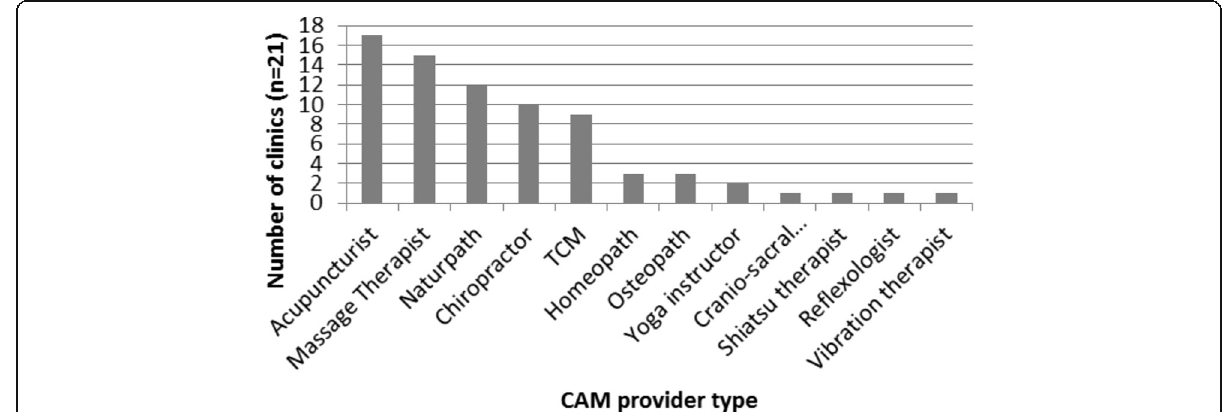
Fig. 1 Number of study sites providing services delivered by CAM providers